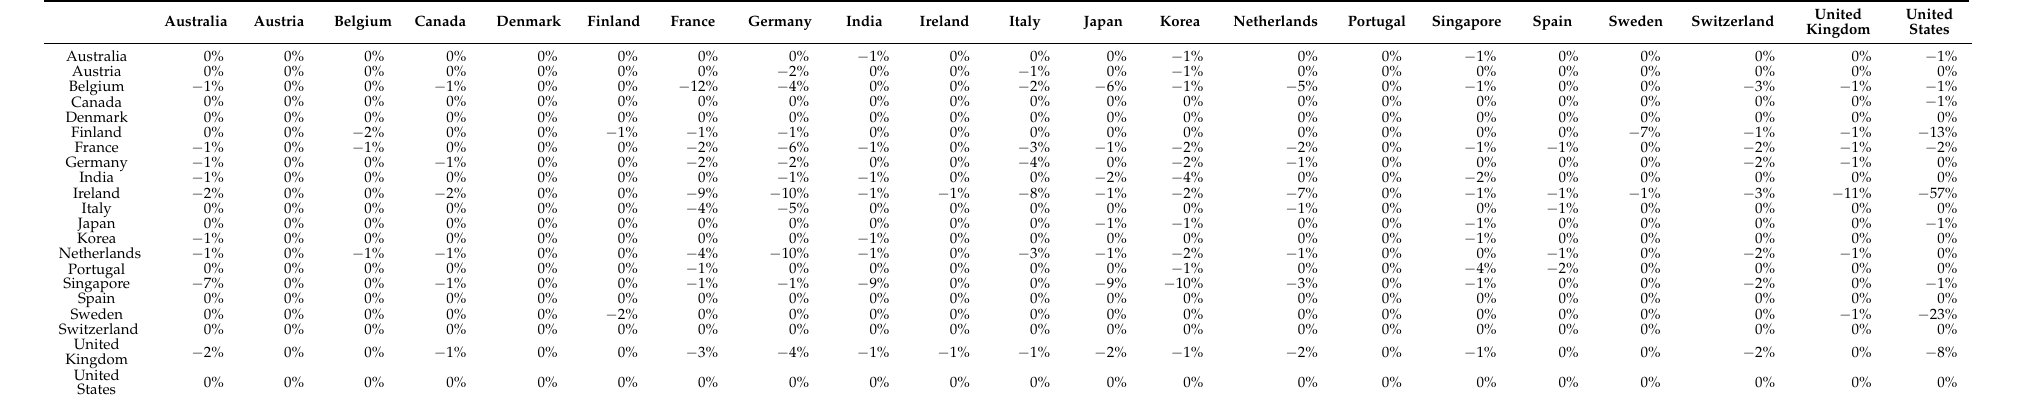
Table 6. Variation in countries’ systemic risk contributions when the column header country is not borrowing from other countries